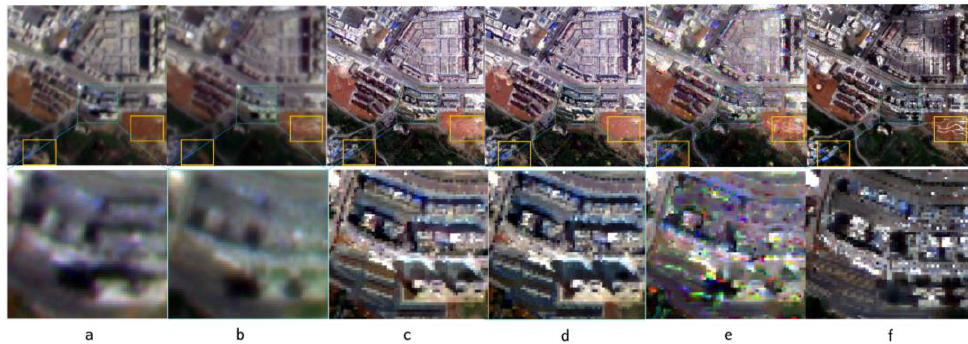
Figure 4. ( a ) PS image on 15 April; ( b ) PS image on 10 July; ( c ) fusion image by FSDAF on 10 July; ( d ) fusion image by STDFA on 10 July; ( e ) fusion image by Fit_FC on 10 July; ( f ) GF-2 verification image on 13 July.